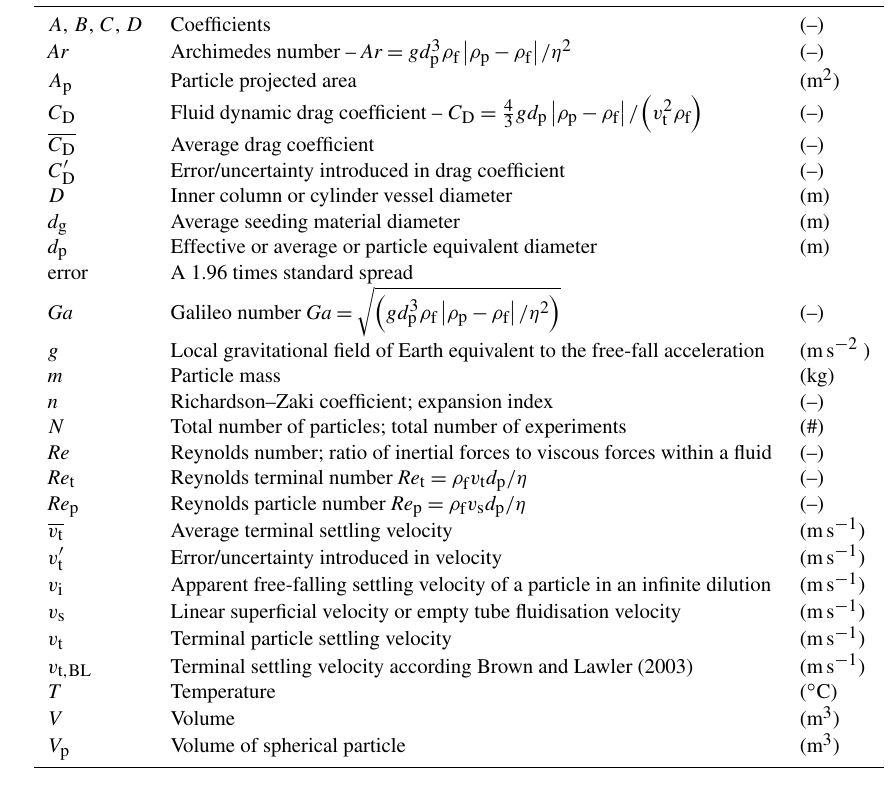
Table A1. Symbols.